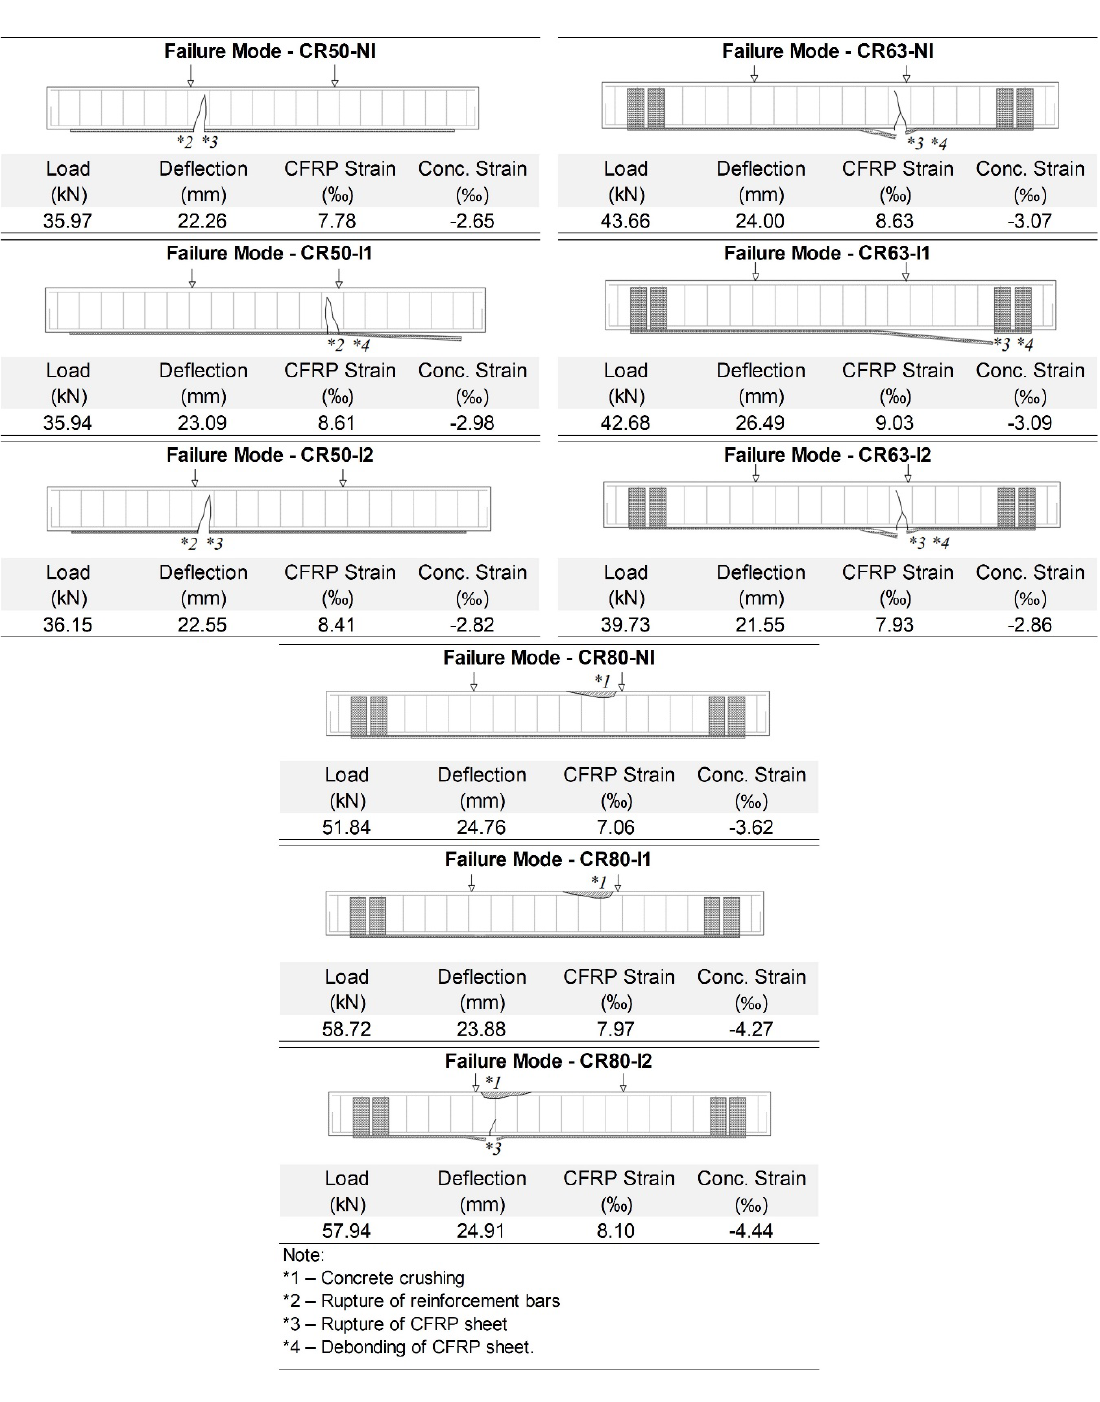
Figure 16. Failure modes displayed by the specimens. Load (kN) represents the sum of the loads (2 P ) applied to the